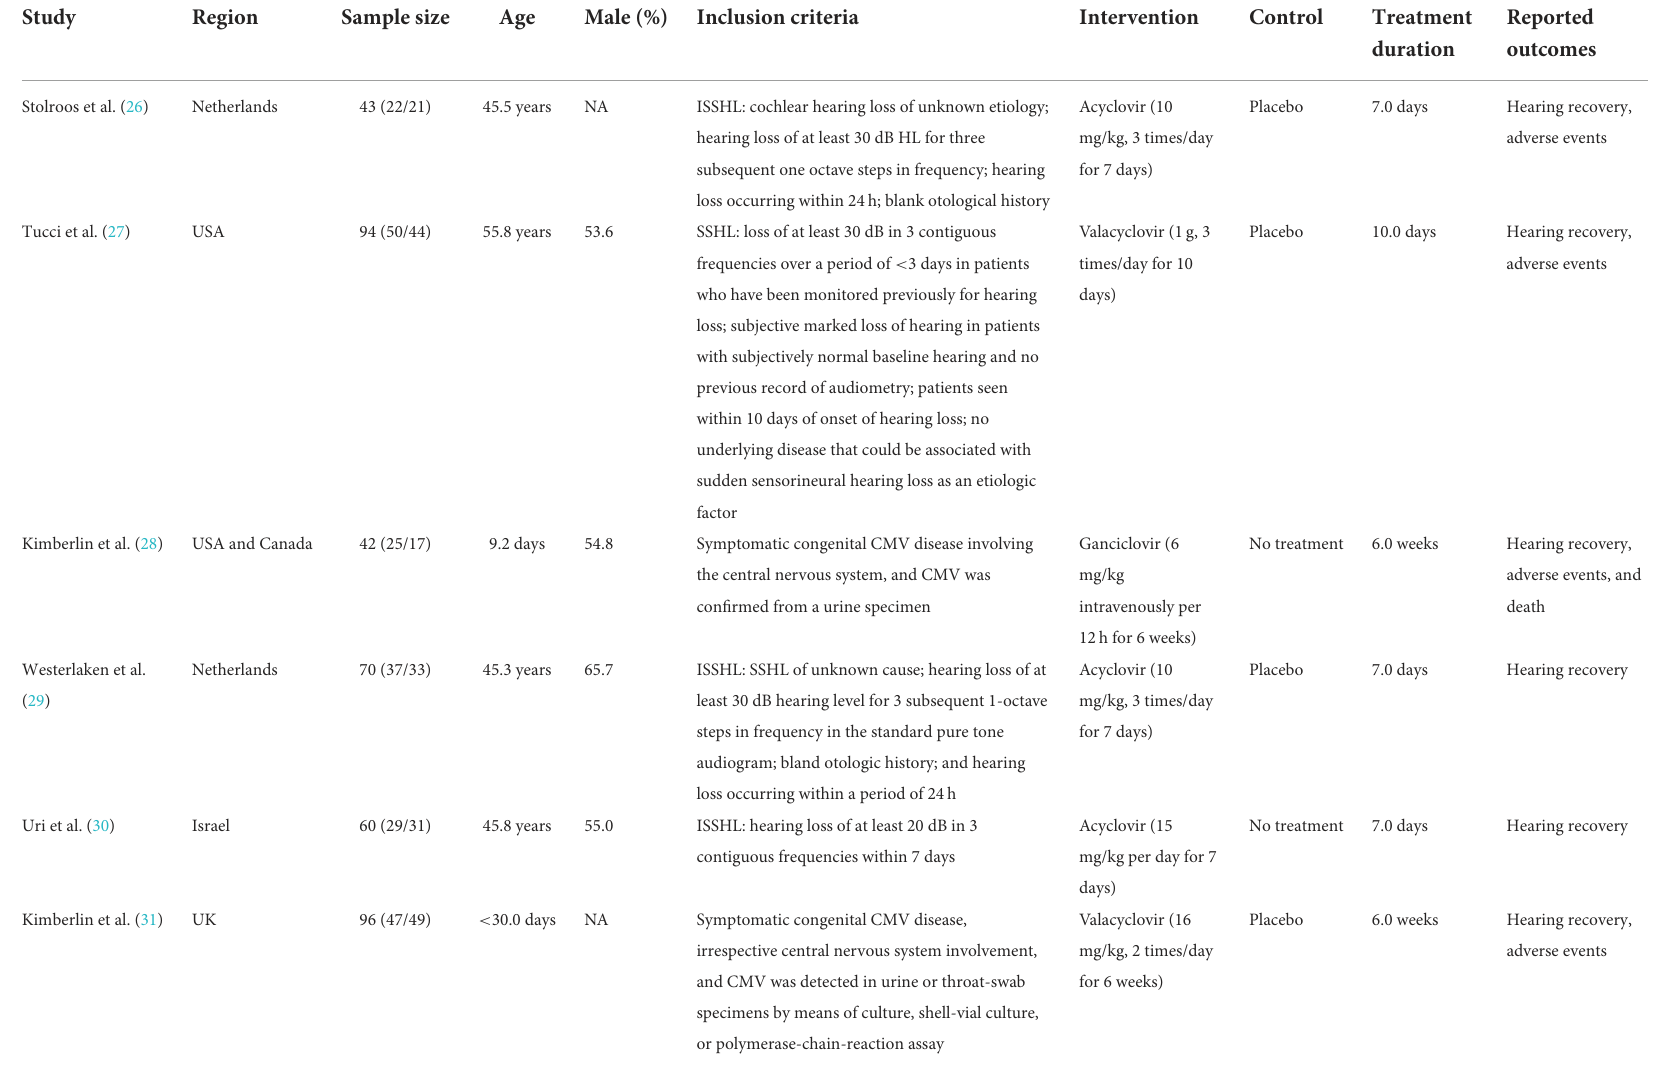
TABLE 1 The baseline characteristics of included